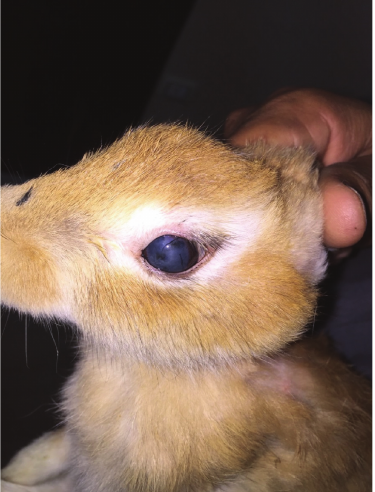
Figure 4: First day after injection with corneal oedema.